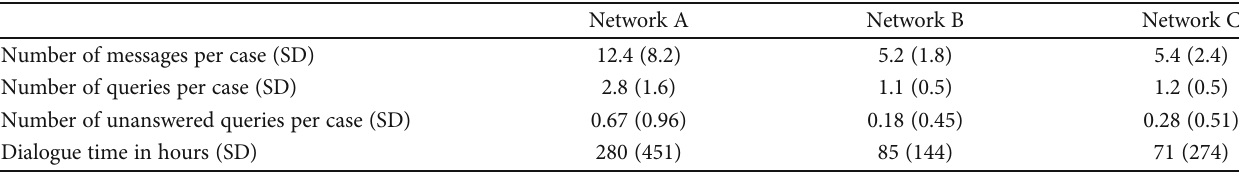
Table 6: Message activity in the fi rst six months of 2020.